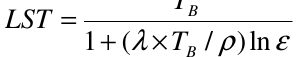
Figure 1: position of the study area in Alborz Mountain